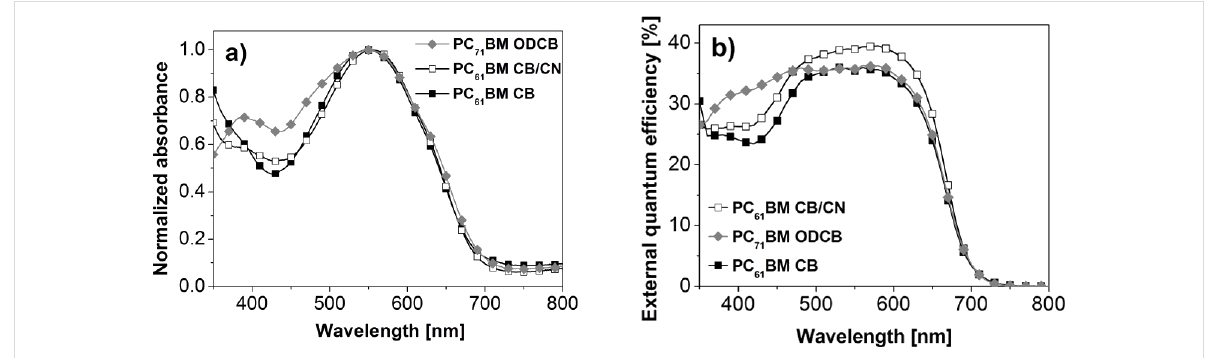
Figure 5: (a) Normalized absorption spectra of DCV5T-Bu 4 :PC 61 BM blends spin-coated from CB, CB:CN (0.375% wt./vol.) as well as DCV5T- Bu 4 :PC 71 BM blends spin-coated from ODCB. All films were spin-coated at 80 °C to accurately reproduce the active layer. (b) Spectral response plot of BHJ devices made using DCV5T-Bu 4 in combination with PC 61 BM (CB, CB:CN) or PC 71 BM (ODCB). Device structure: ITO|PEDOT:PSS| DCV5T- Bu 4 :PCBM|LiF|Al.